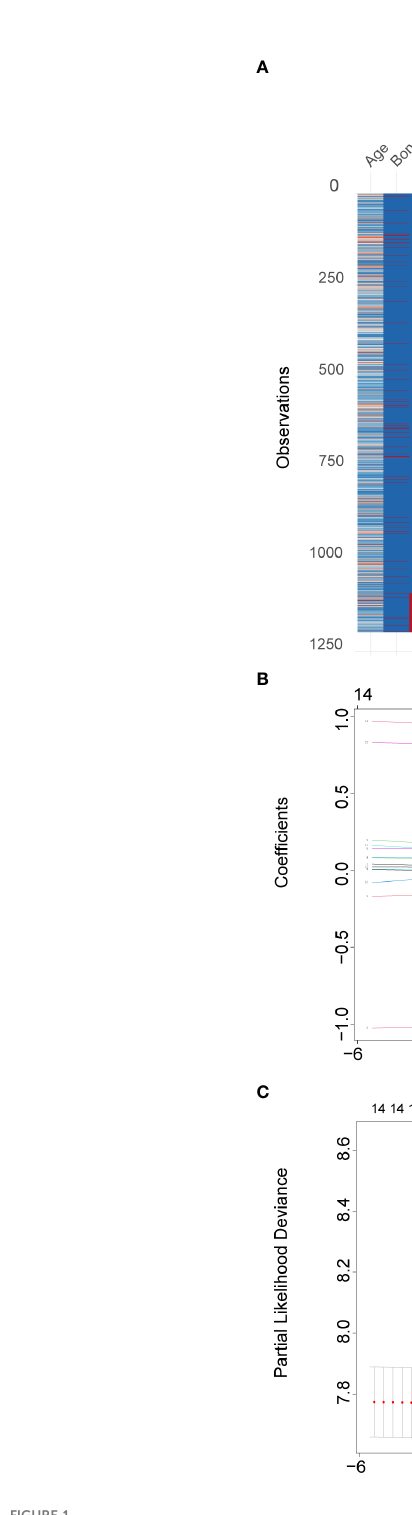
FIGURE 1 Overview of the total datasets combining the training set and validation set and LASSO model pro fi le plots. (A) , Heatmap of each clinical factor in the total datasets. (B) , Coef fi cient pro fi le plots showing how the size of the coef fi cients of clinical factors shrinks with increasing value of the penalty, with the factors and their regression coef fi cients selected for the model based on the optimal for the LASSO model. (C) , Penalty plot for the LASSO model; color error bars indicate standard error. LASSO, least absolute shrinkage and selection